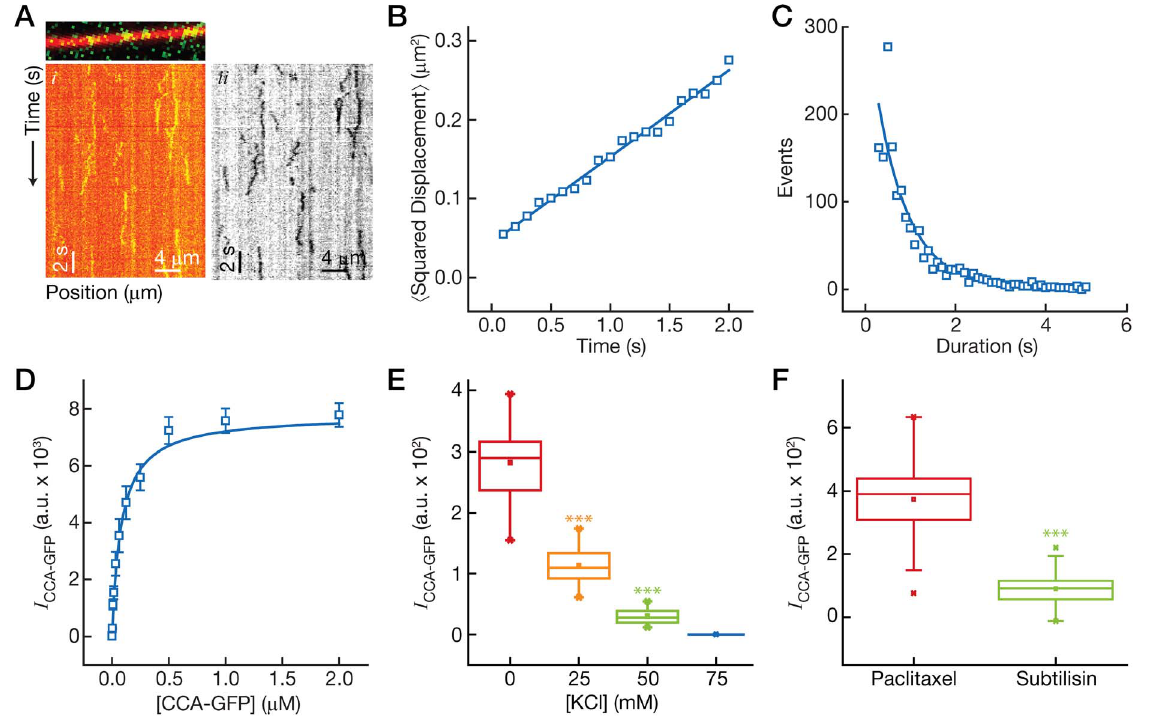
Figure 2. The CCA diffuses on microtubules via electrostatic interactions. ( A ) Still image (top) and kymographs (bottom) of the CCA-GFP (green) interacting with microtubules (red). The back-and-forth movements of a 1D random walk are evident. ( i ) A color-combined kymograph of CCA-GFP diffusion. ( ii ) An inverted grayscale image of the CCA-GFP signal shown in ( i ). ( B ) Plot of the mean squared displacement, S x 2 T against time for the CCA-GFP. A linear relationship is observed, and slope of the fit (blue line), m , is related to the diffusion coefficient by m ~ 2 D . ( C ) Histogram of the duration of CCA-GFP binding events. An exponential decay fit (blue line) gives a mean duration of t =1.5 s. ( D ) Plot of the intensity of the CCA- GFP on the microtubule lattice against the concentration of the CCA-GFP. The data is well described by a conventional binding isotherm (blue line). ( E ) Box plot of the intensity of the CCA-GFP on microtubules at four different salt concentrations. ( F ) Box plot of the intensity of the CCA-GFP on microtubules for paclitaxel-stabilized microtubules and subtilisin-digested microtubules (labeled).